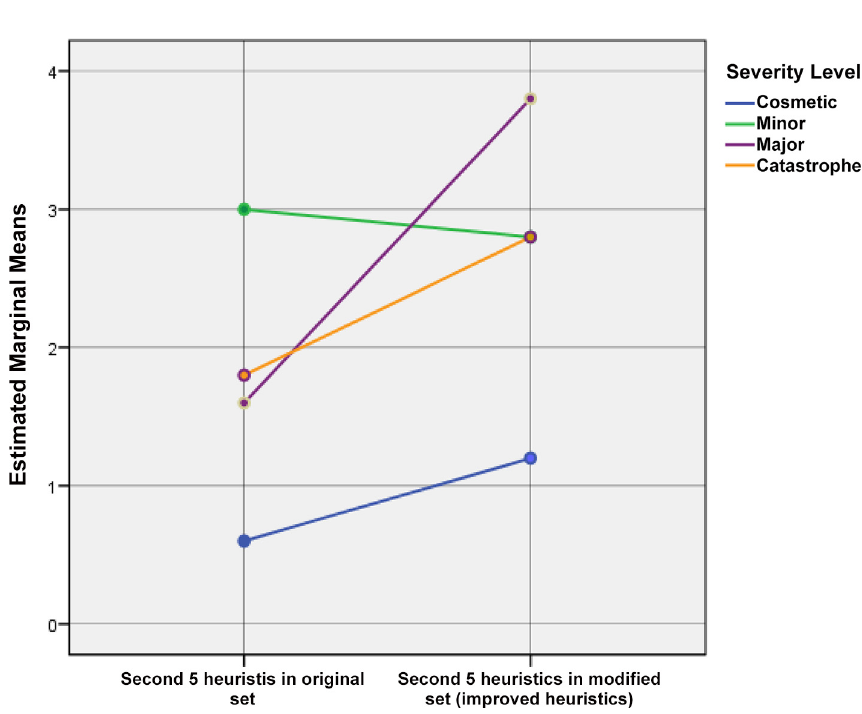
Fig 10. Estimated marginal means of problem identification by groups 2 and 4 at different severity levels.